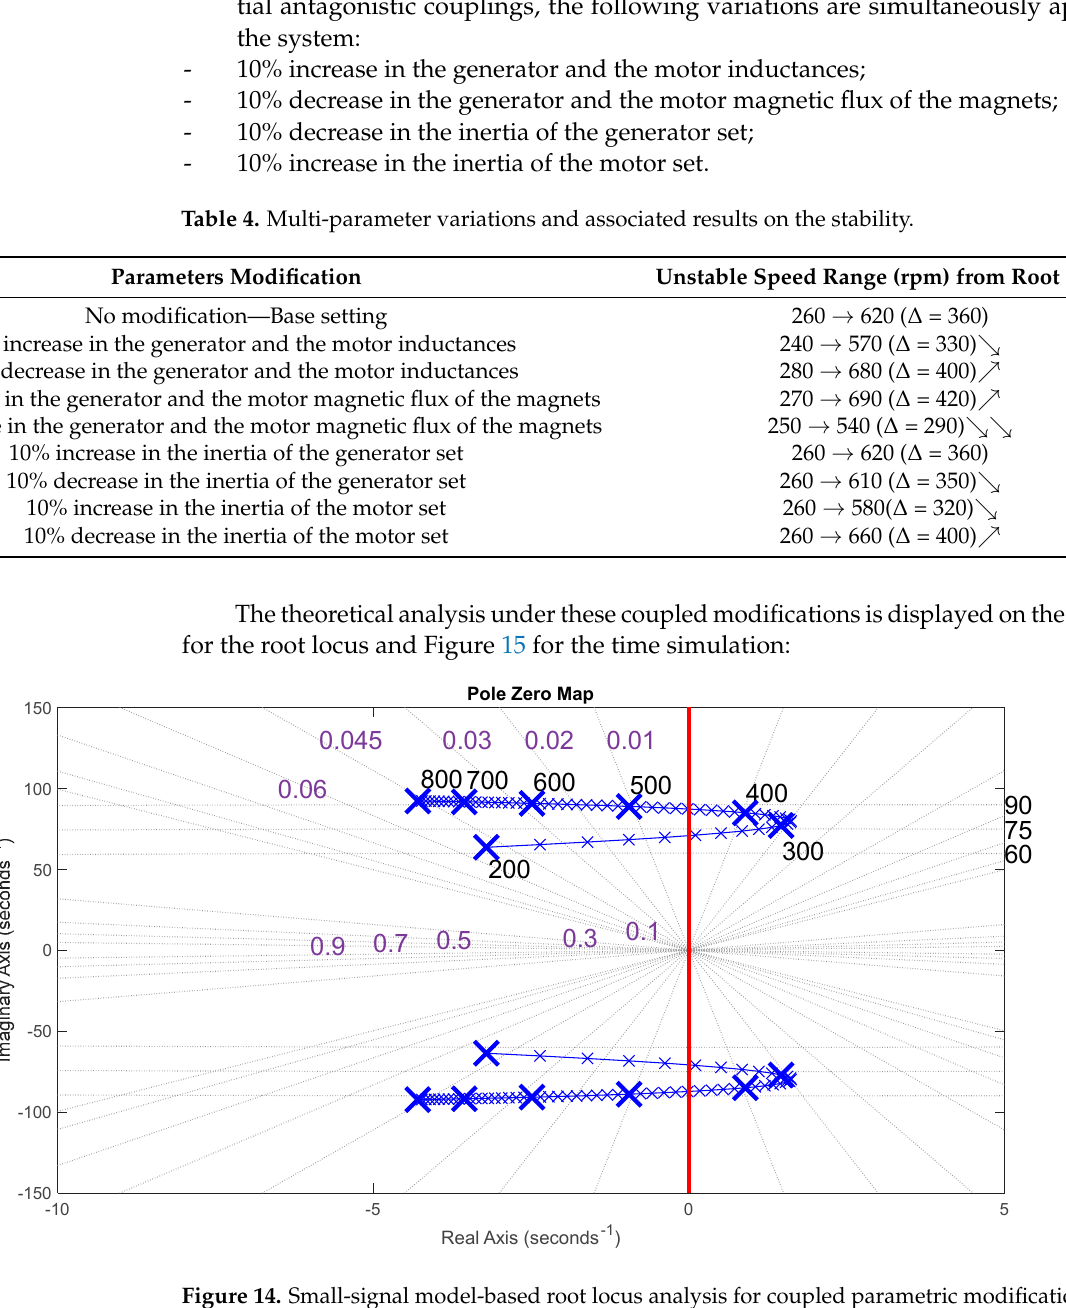
Figure 15. Time simulation analysis for coupled parametric modifications with a bandwidth of 1 Hz for the generator speed control and with coupled modifications of electric and mechanical parameters.